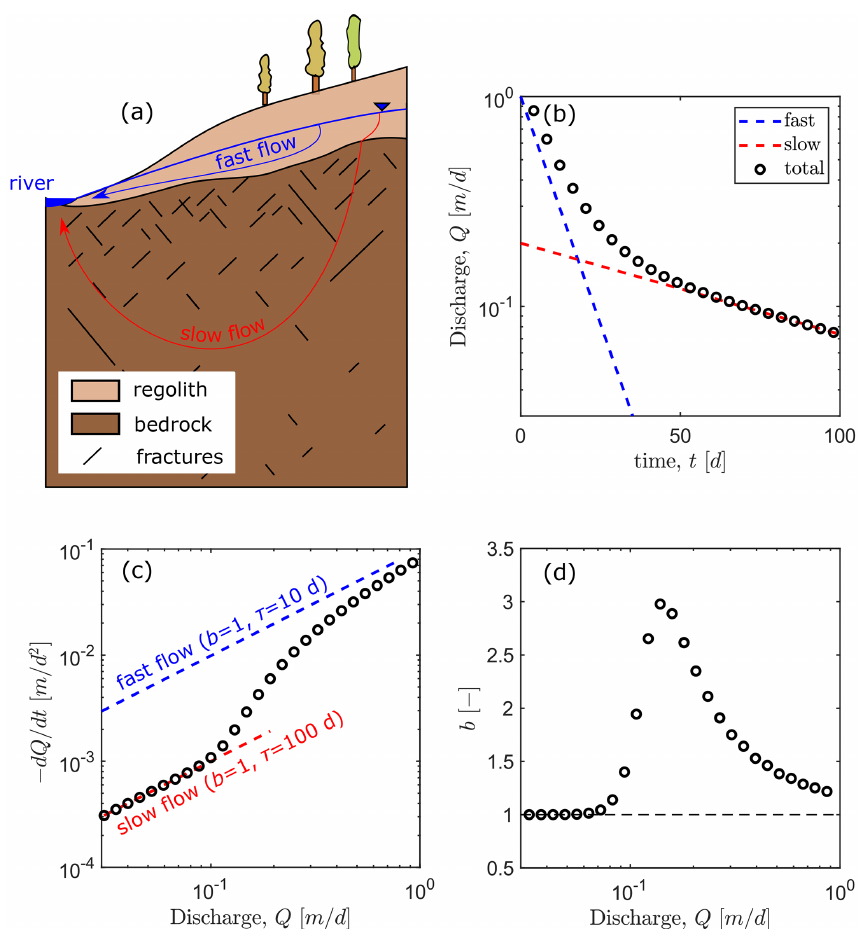
Figure 1. (a) Conceptual model of a compartmentalized hillslope with groundwater flow distributed between fast flow within the shallow regolith/fractured aquifer and slow flow in the underlain bedrock. (b) Theoretical streamflow behaviour considering two linear reservoirs ( b = 1) in parallel with fast (blue line; τ = 10d) and slow (red line; τ = 100d) drainage timescales. (c) Resulting recession plot − d Q/ d t = f (Q) . (d) The evolution of b as a function of discharge identifying high values during the transitional flow regimes up to 3 in this